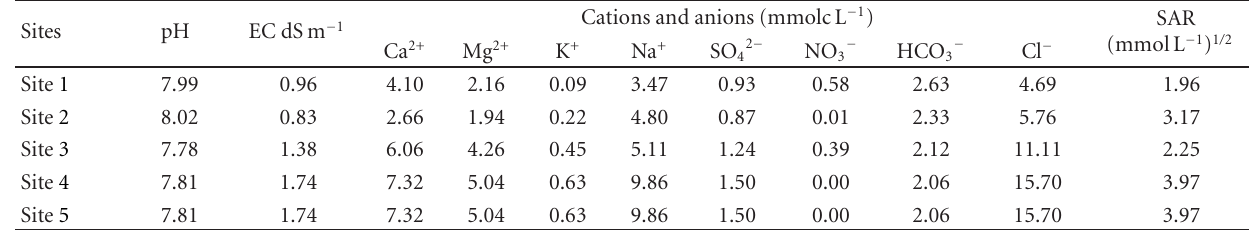
Table 2: Irrigation water quality in the investigated